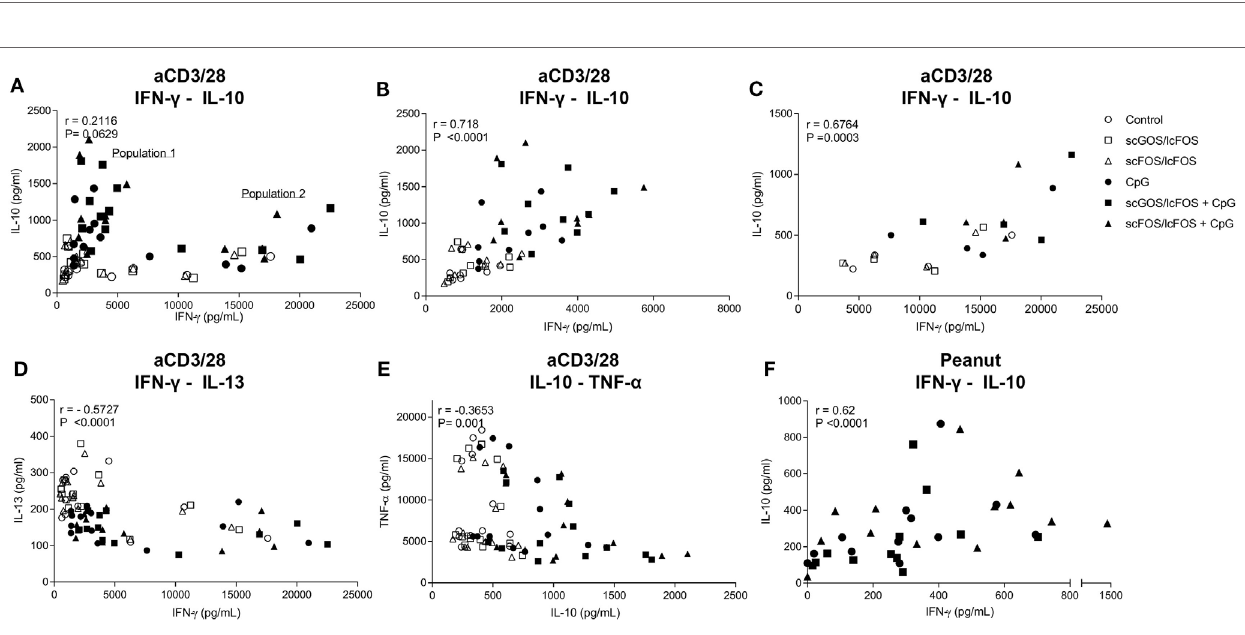
FigUre 3 | Enhanced production of IL-10 and IFN- γ by aspecific or peanut-specific activated peripheral mononuclear cells upon combined exposure of intestinal epithelial cells (IECs) to CpG oligodeoxynucleotides (ODN) and oligosaccharides. Exposure of IECs to CpG ODN in combination with short-chain galacto- oligosaccharides and long-chain fructo-oligosaccharides (scGOS/lcFOS) (GF) or scFOS/lcFOS (FF) enhanced basolateral IFN- γ and IL-10 production in the aspecific model (a,B) . IL-13 production was decreased in the aspecific model upon exposure of IECs to CpG ODN and was further decreased by oligosaccharides (c) . TNF- α production was decreased in the combined presence of scGOS/lcFOS and scFOS/lcFOS (D) . Only scFOS/lcFOS was able to enhance basolateral IFN- γ and IL-10 production induced by CpG ODN in the peanut-specific model (e,F) . IL-13 was measured after restimulation in four peanut-allergic patients (g) . Data are represented as ratio’s compared to the medium control and represent n = 12–13 peanut-allergic patients, mean ± SEM, * P < 0.05, ** P < 0.01, *** P < 0.001 by one-way